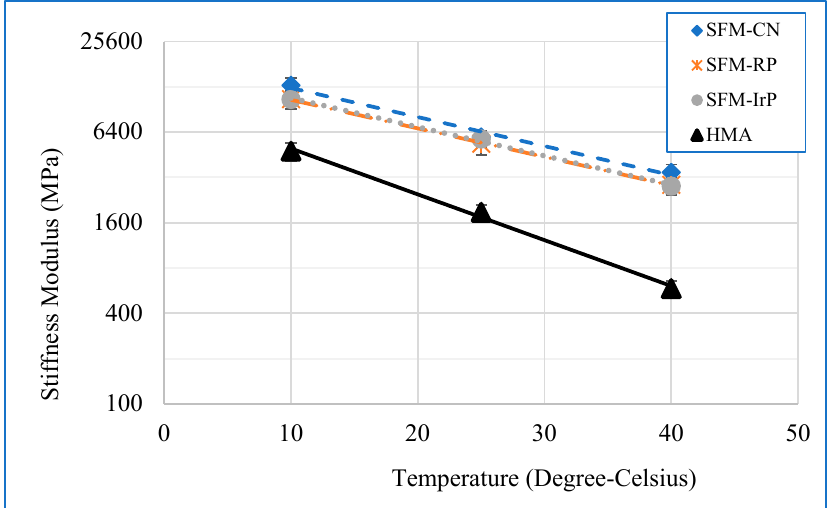
Figure 7. Stiffness modulus of semi-flexible and HMA mixture at different temperatures .